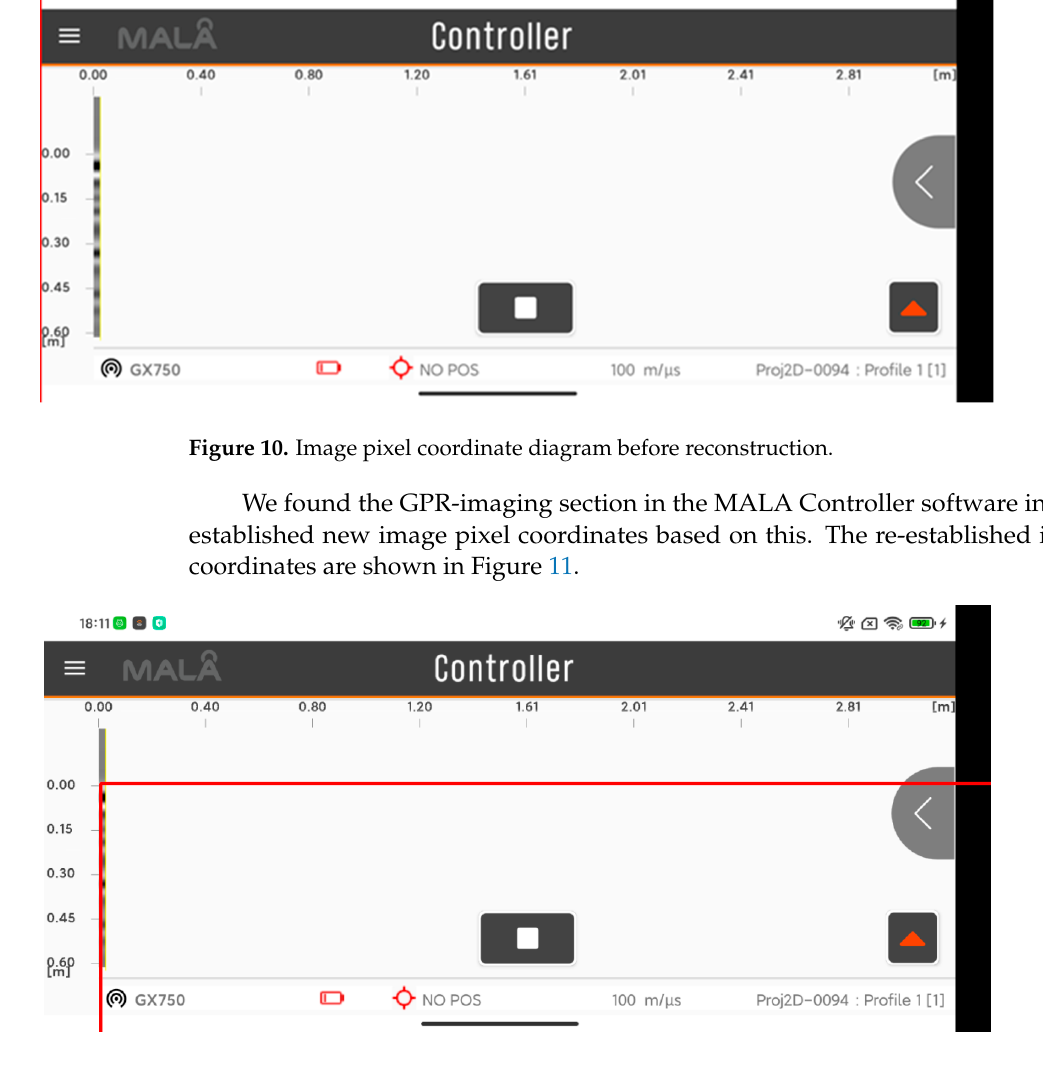
Figure 9. The ABD tool captures part of the process of the mobile phone screen.